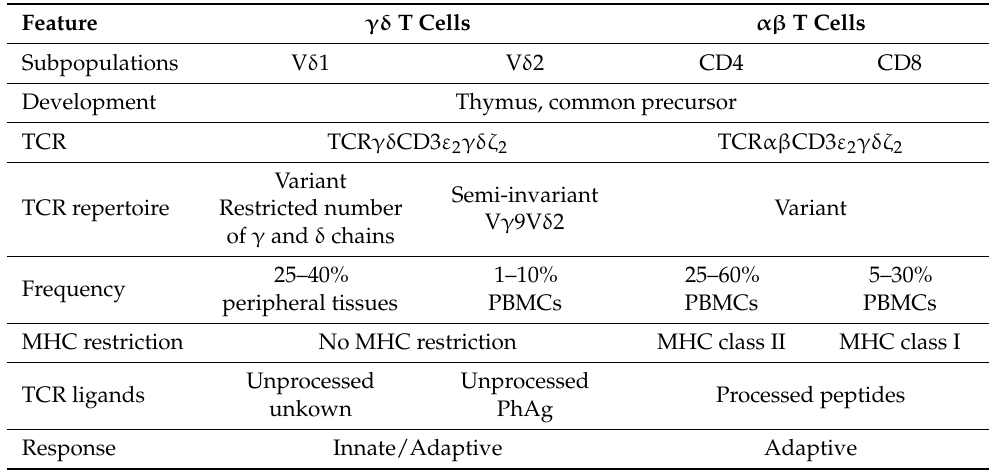
Table 1. Major differences among the main human γδ T and αβ T cell